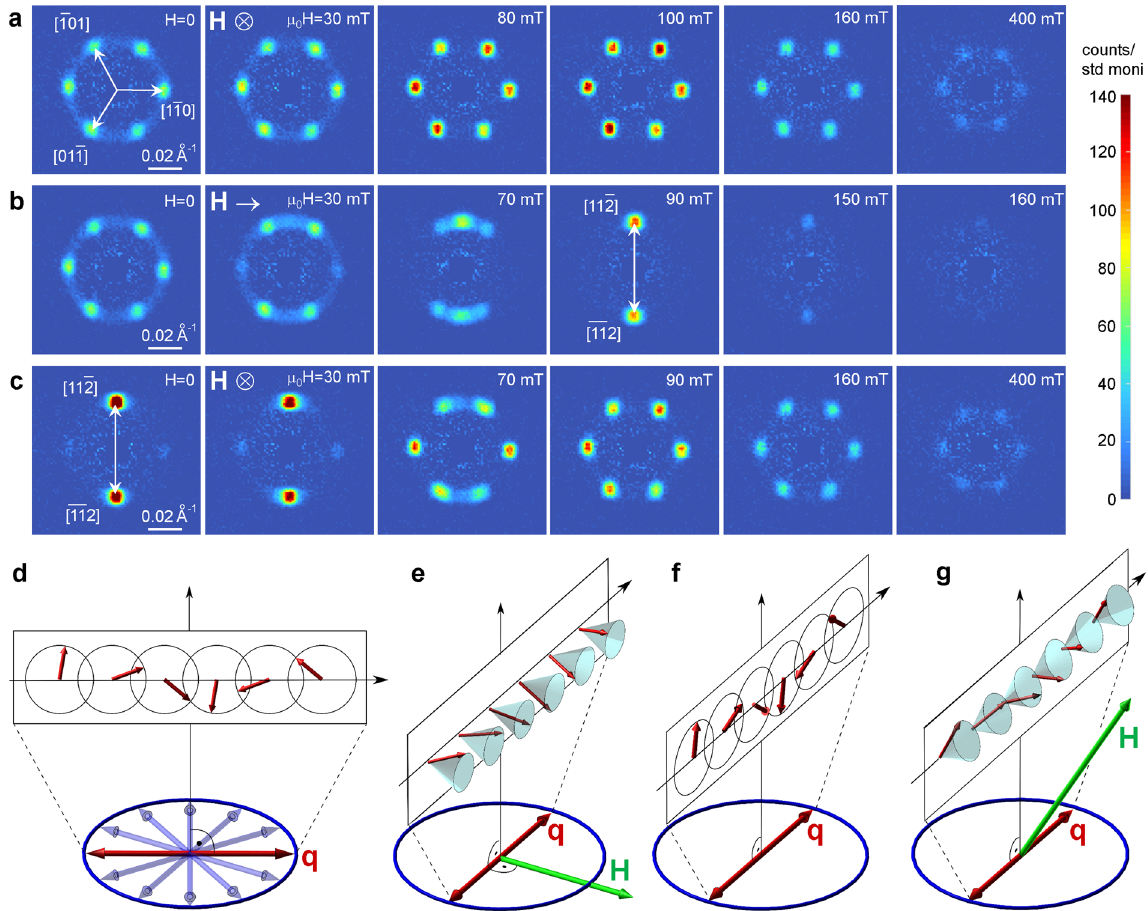
Figure 4. Modulated magnetic structures in GaV 4 Se 8 at 12 K. ( a ) Representative SANS images recorded in the (111) plane with magnetic field applied along the [111] axis. The first image was taken after zero-field cooling. The magnetic field increases from left to right. ( b ) The same as for panel (a) but with field applied along the [1 1 0] axis. ( c ) After the measurements in H [110] , the magnetic field was decreased to zero and SANS images were again recorded in the (111) plane with H ‖ [111]. The colour scale on the right is common for panels (a–c). ( d ) Schematic of cycloidal structures present with arbitrary q-vectors distributed around a ring in the rhombohedral plane. For clarity, the cycloid is shown only for a single q-vector. ( e ) Magnetic fields applied perpendicular to the polar axis establish a transverse conical state with single q-vector normal to the field. ( f ) After switching off the magnetic field, this conical structure relaxes back to a cycloid preserving the single q-vector state. ( g ) For H with oblique angles, the field component normal to the polar axis distorts the cycloid into a tilted conical structure, where the axes of the cones are tilted away from the polar axis but are not exactly parallel with the